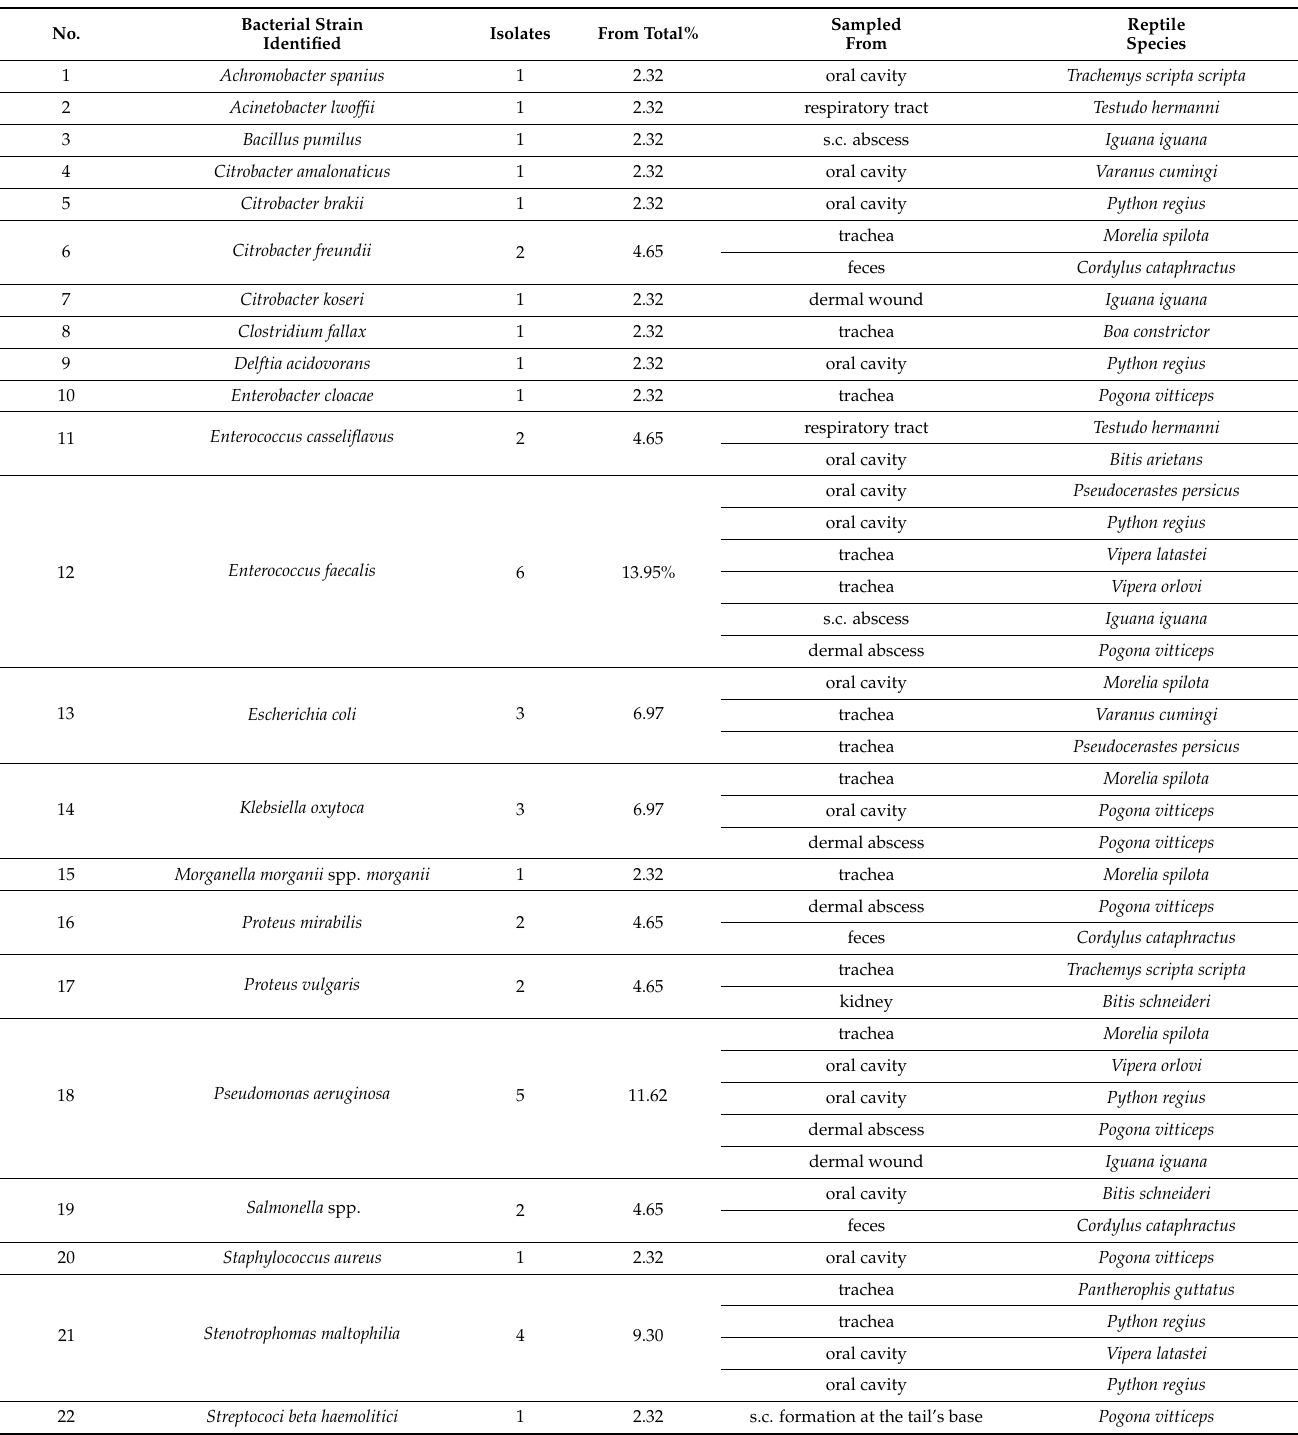
Table 1. Presentation of cases: bacterial media, reptiles, and antibiotics